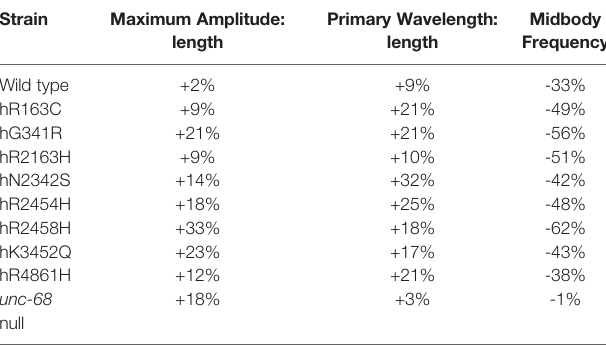
TABLE 2 | Mean percentage change from young adult to old adult in maximum amplitude and primary wavelength, both corrected for worm length, and in midbody frequency.